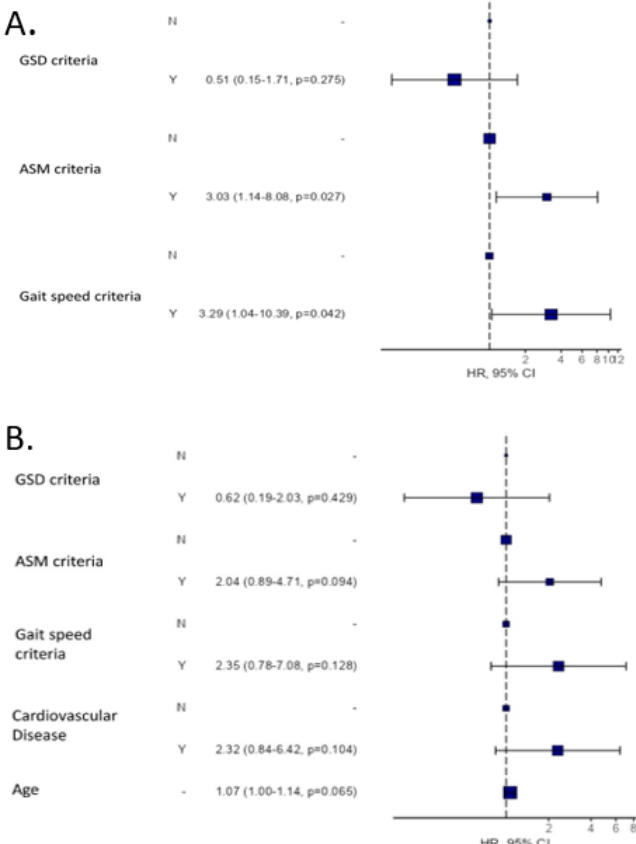
Figure 2. All-cause mortality risk analysis according to the EGWSOP2 criteria at 24 months. ( A ) Univari-